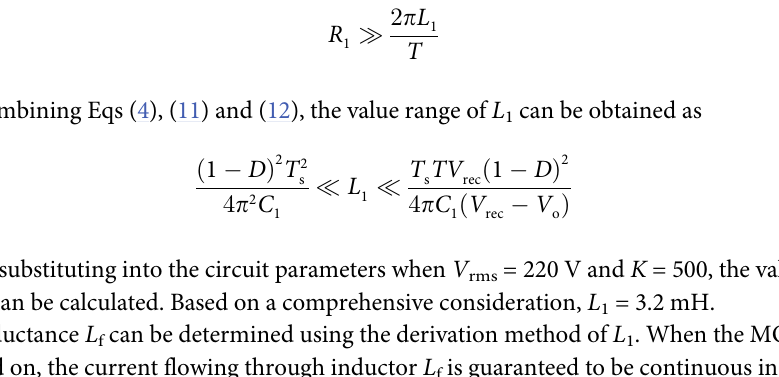
Table 2. Analysis of circuit operating characteristics under different K values at η =0.85. K 1000 Duty cycle D when M s =0.064 Duty cycle D when M =0.077 s Duty cycle D when M s